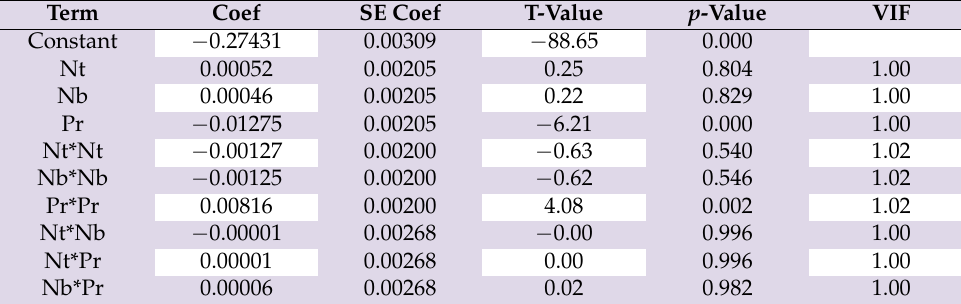
Table 10. Coefficients for design